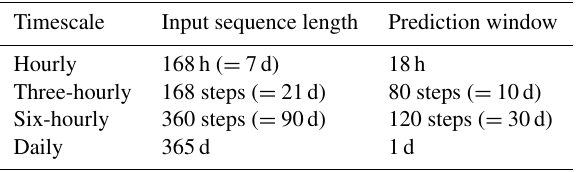
Table 2. Input sequence length and prediction window for each pre- dicted timescale. The daily input merely acts as a means to extend the look-back window to a full year without generating overly long input sequences; we did not evaluate the daily predictions. The spe- cific input sequence lengths were chosen somewhat arbitrarily, as our intent was to demonstrate the capability rather than to address a particular application or operational